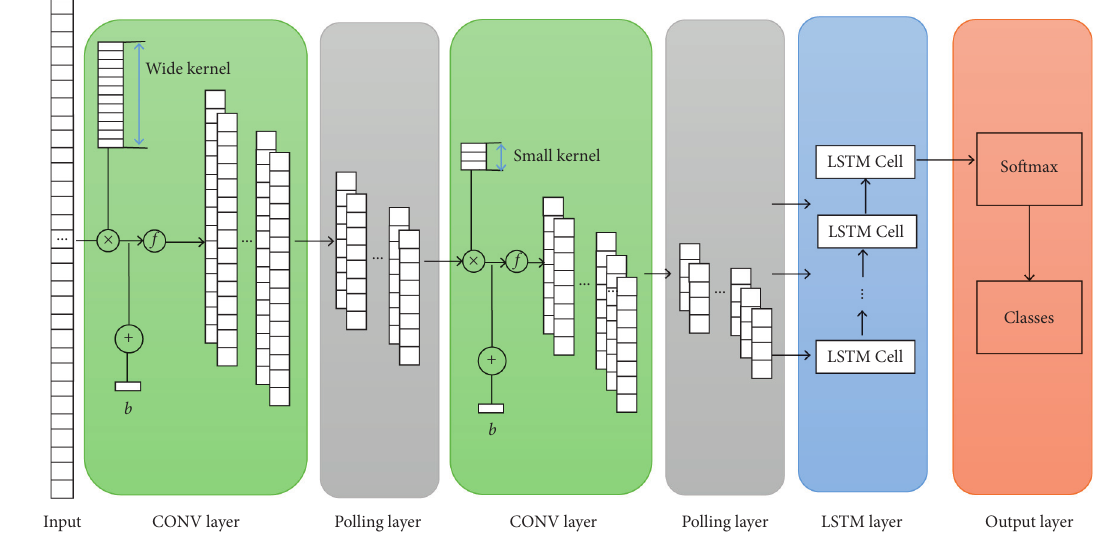
Figure 3: The structure of the proposed model. Table 1: Technical parameters of end mills.